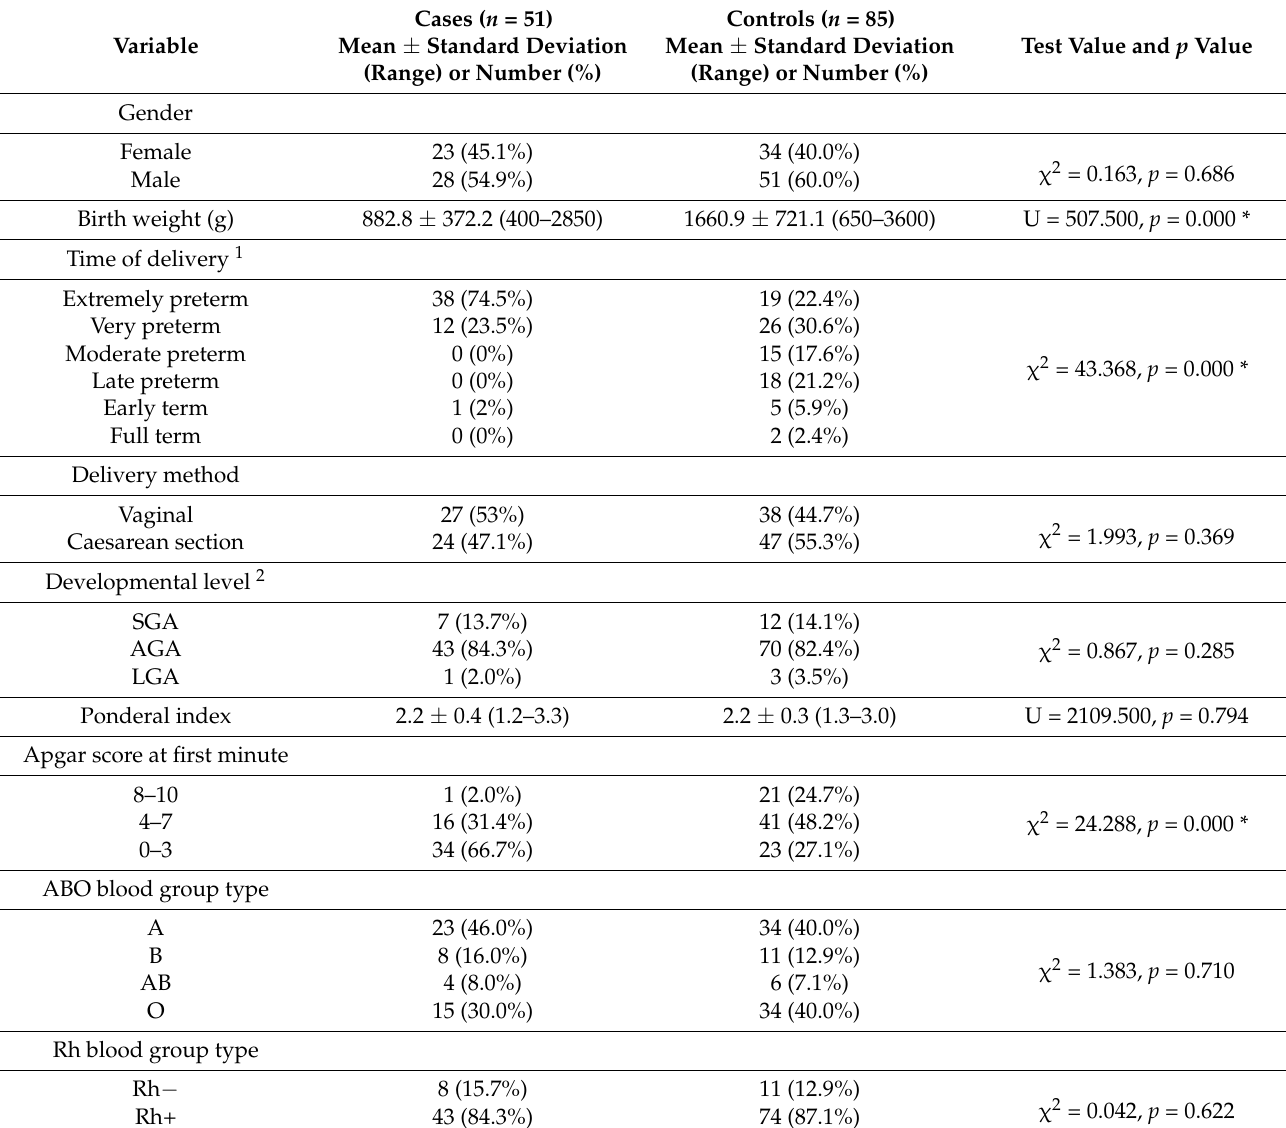
Table 2. The basic characteristics of the newborns at